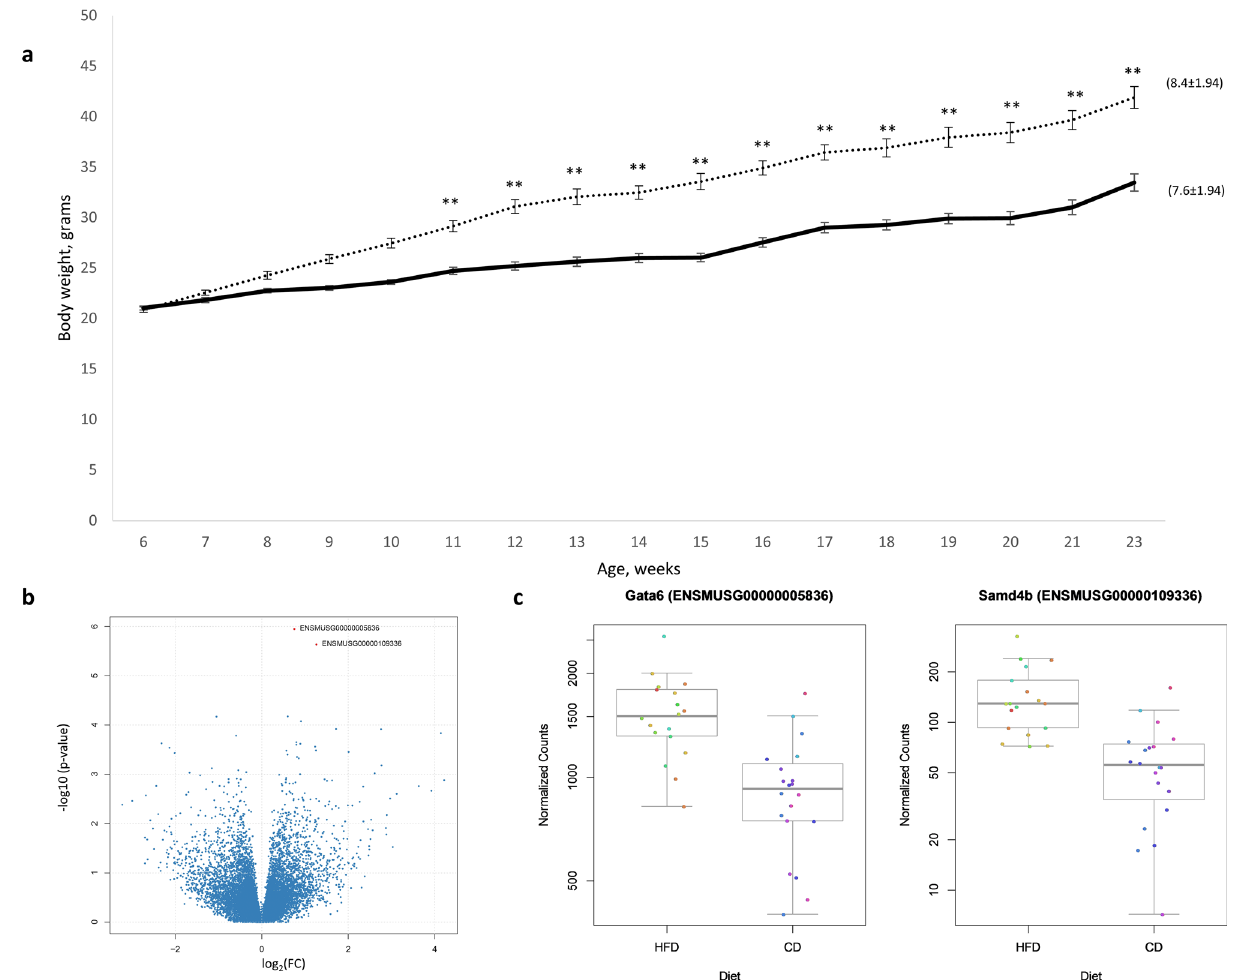
Figure 1. ( a ) Average body weight for male mice fed a high fat diet (HFD) or a control diet (CD) from 6 to 23 weeks of age. Mean body weight ± standard error of the mean (SEM). p -values < 0.05 were considered statistically significant, ** for p < 0.01. Solid line = CD (n = 10). Dashed line = HFD (n = 10). Data in brackets indicates the average number of 8-cell embryos recovered for each group (ns). ( b ) Volcano plot showing log-fold change and −log 10 (p-value) for the comparison HFD vs CD embryos. ( c ) Gata6 and Samd4b expression in 8-cell embryos fathered by males on a high fat diet and control diet. Each dot represents the normalized gene count for each embryo and dot colour indicates “father of